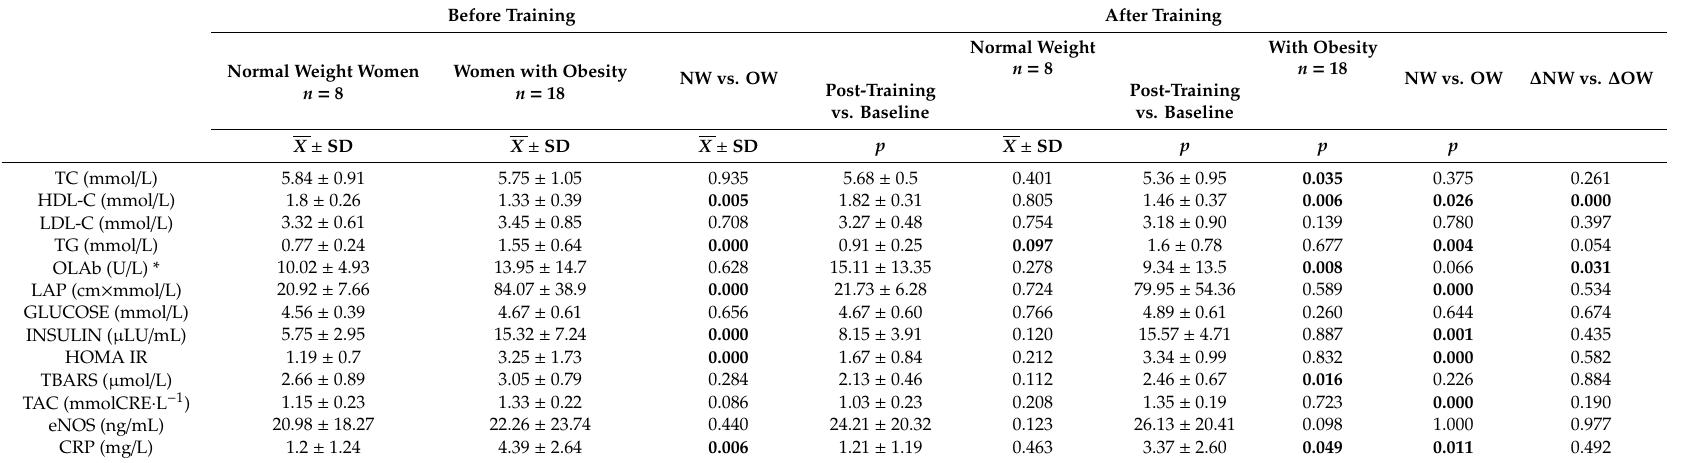
Table 3. Biochemical parameters in the study